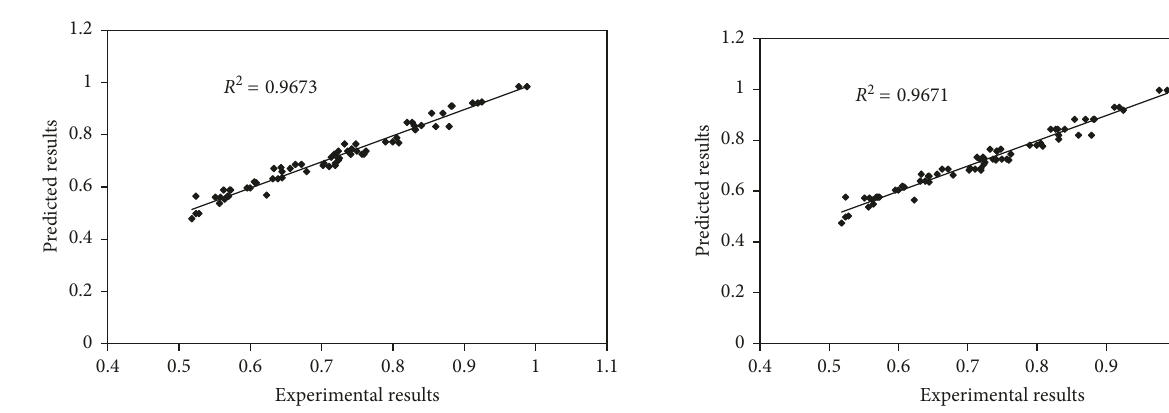
Figure 18: Linear relationship between measured and predicted flexural strengths for the one-step secant backpropagation algo- rithm of